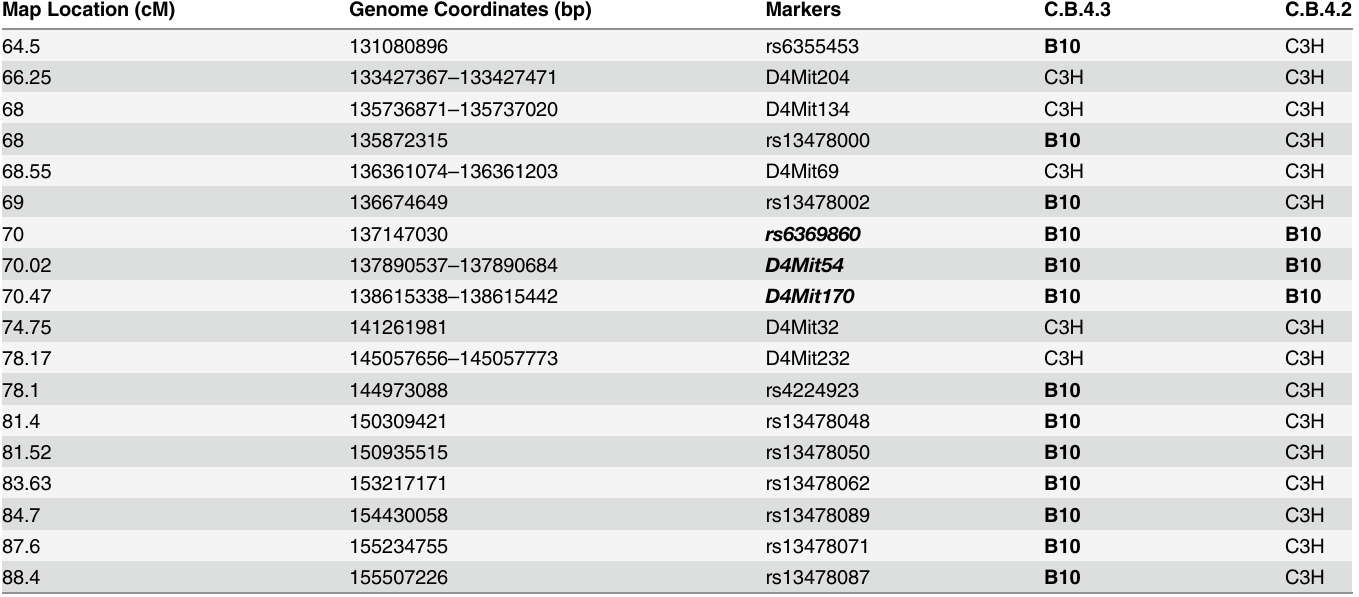
Table 1. Markers for C.B.4.3 and C.B.4.2. Map Location